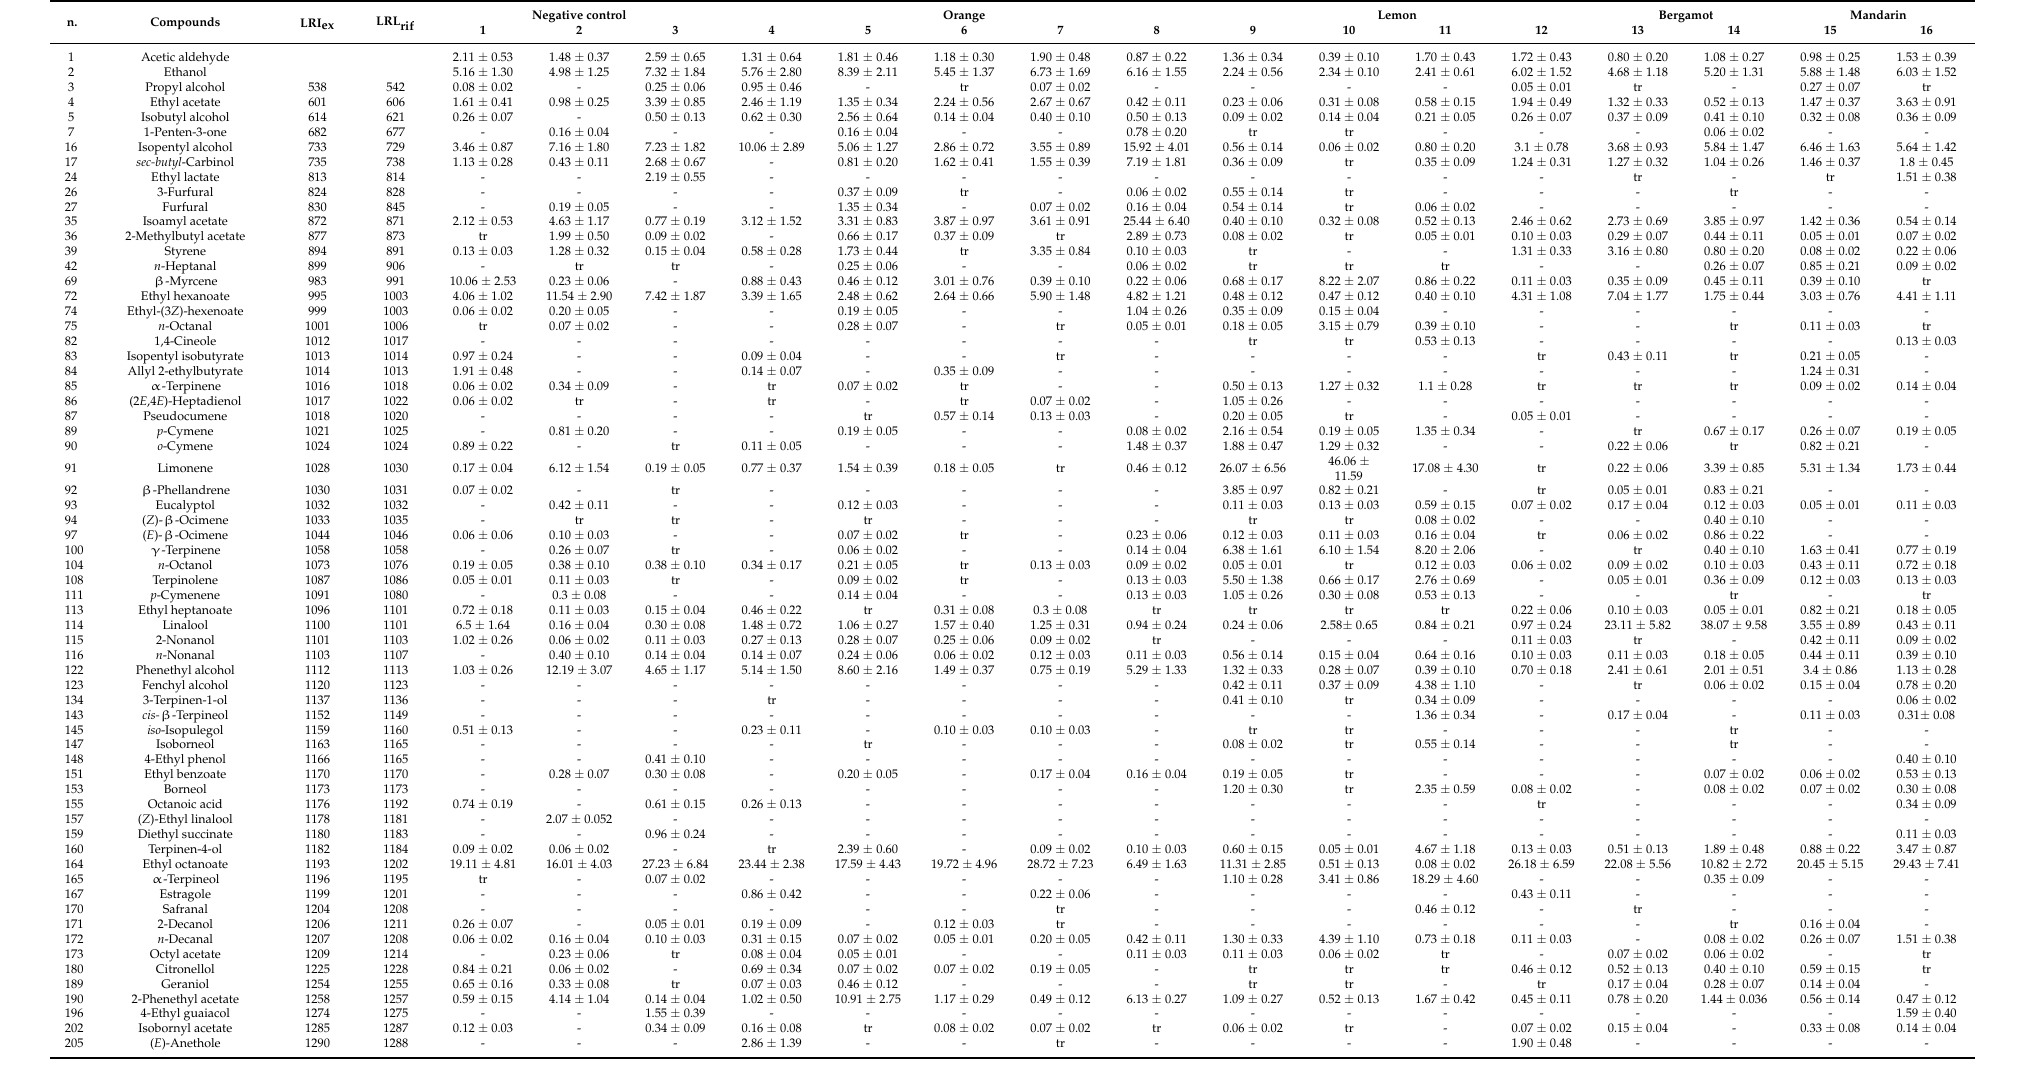
Table 2. Most abundant volatile compounds contained in the samples analysed, expressed in area% ( ± SD) as average of three measurements by GC–FID analysis.